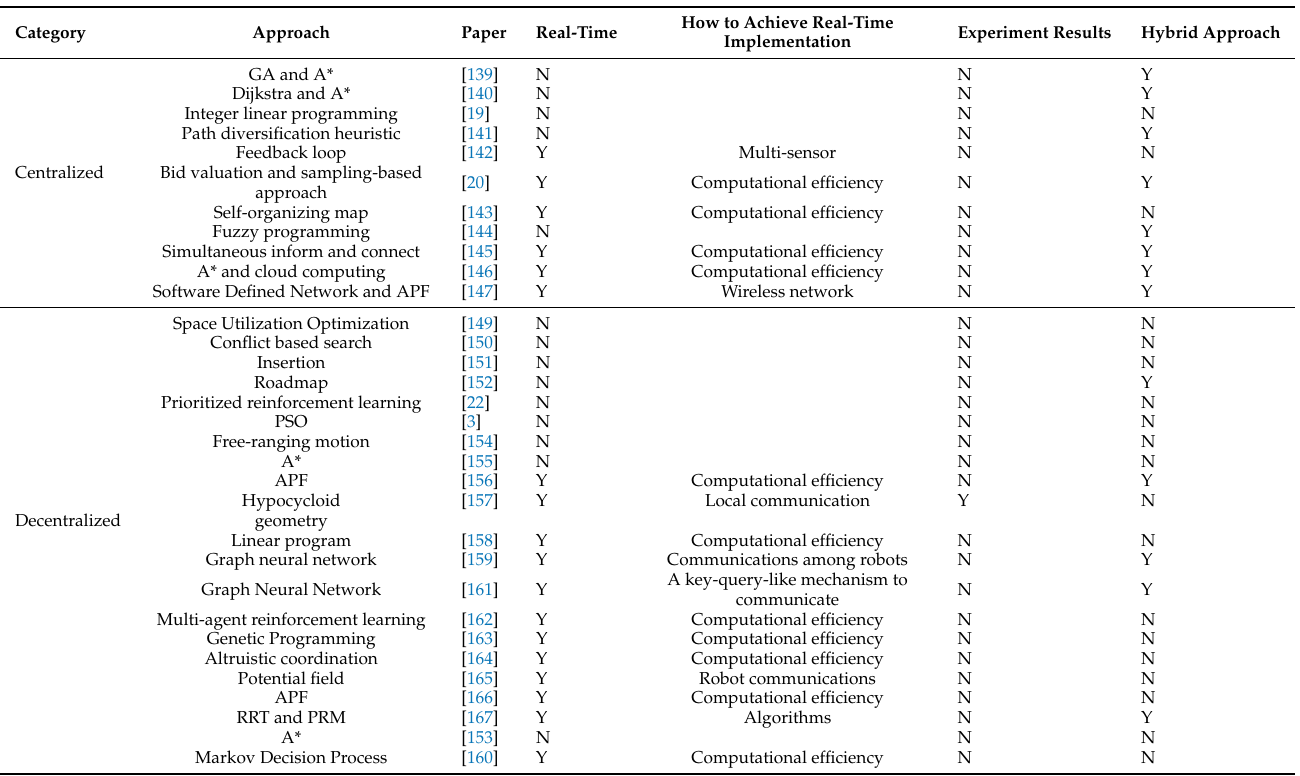
Table 2. Comparison of decision-making